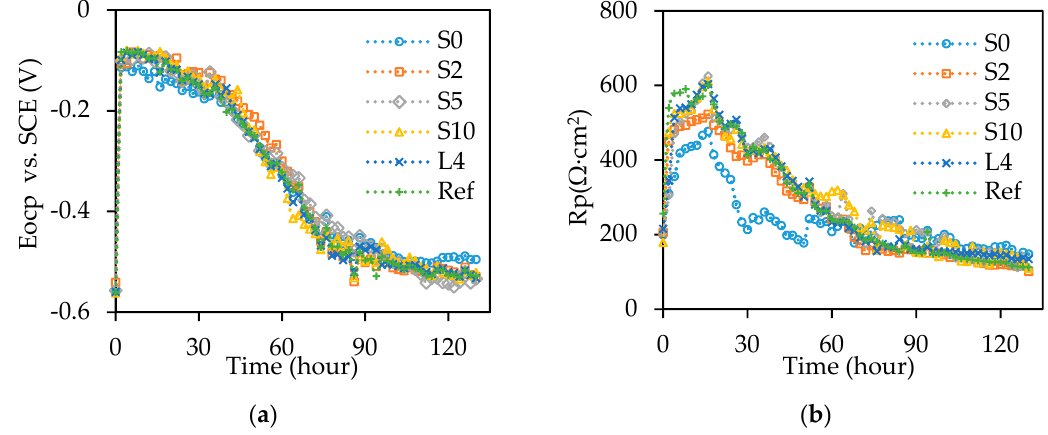
Figure 7. Electrochemical test results of: ( a ) OCP, and ( b ) R P . SCE stands for saturated calomel